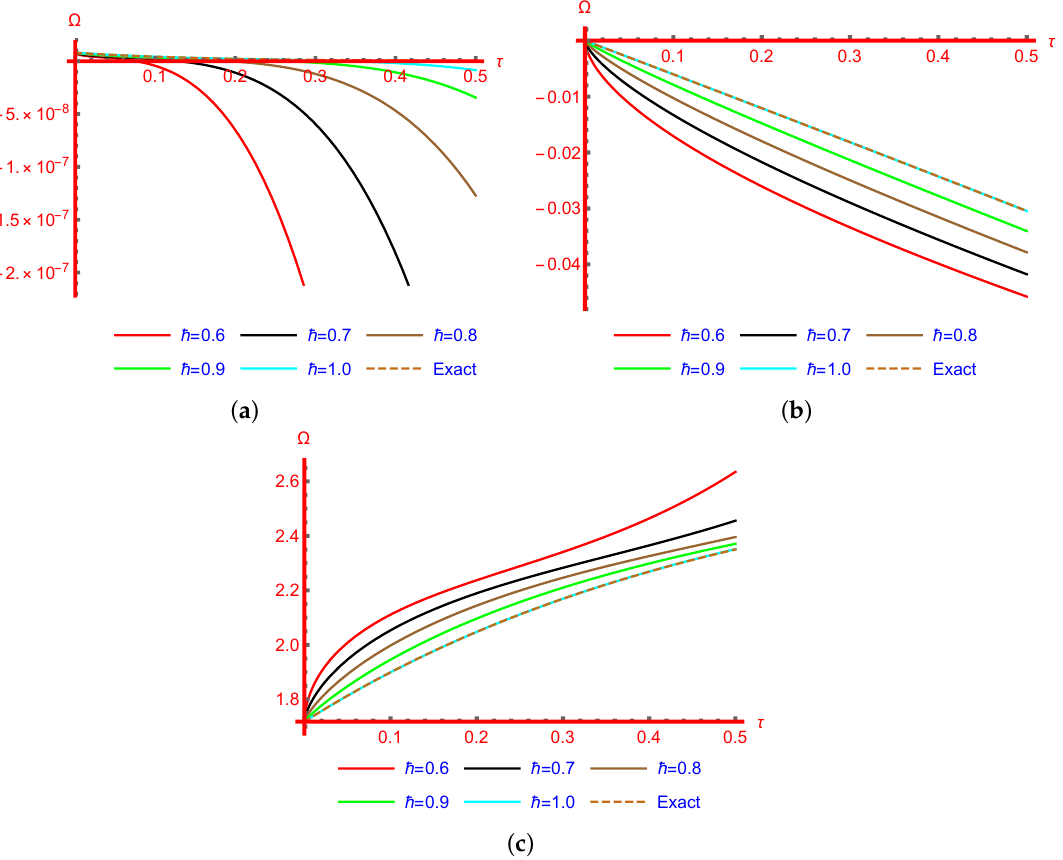
Figure 1. Figure 1 depicts the approximate result of five iterations, as well as the exact result of Ω ( α , τ ) for various values of ¯ h in the range τ ∈ [ 0, 0.5 ] for ( a ): Problem 1, when α = 0.002; ( b ): Problem 2, when α = 1.0; ( c ): Problem 3, when α = 1.0 and ξ =